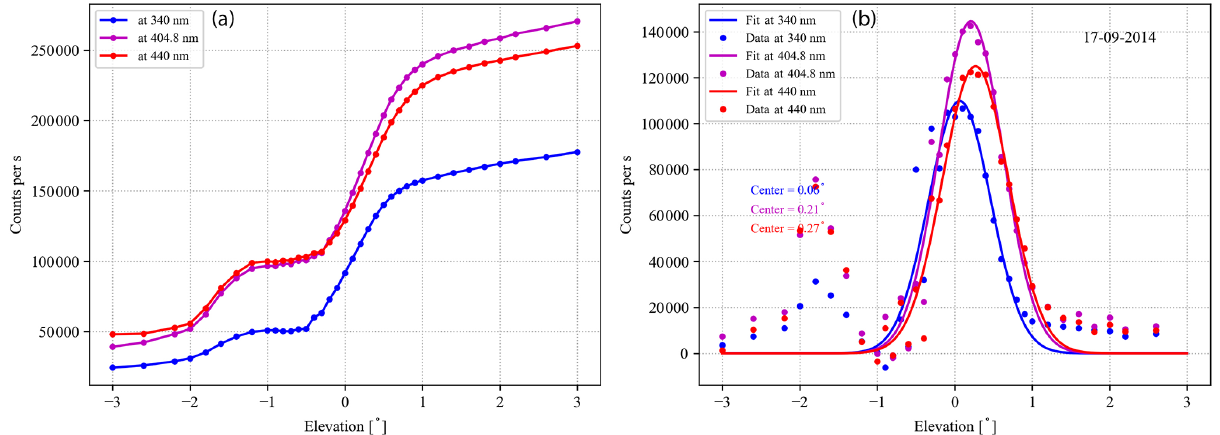
Figure F3. Example plots showing the measured radiance (a) and the derivative of the radiance (b) during a horizon scan spanning elevation viewing angles from − 3 to 3 ◦ . The figures correspond to the horizon scan performed on 17 September 2014.